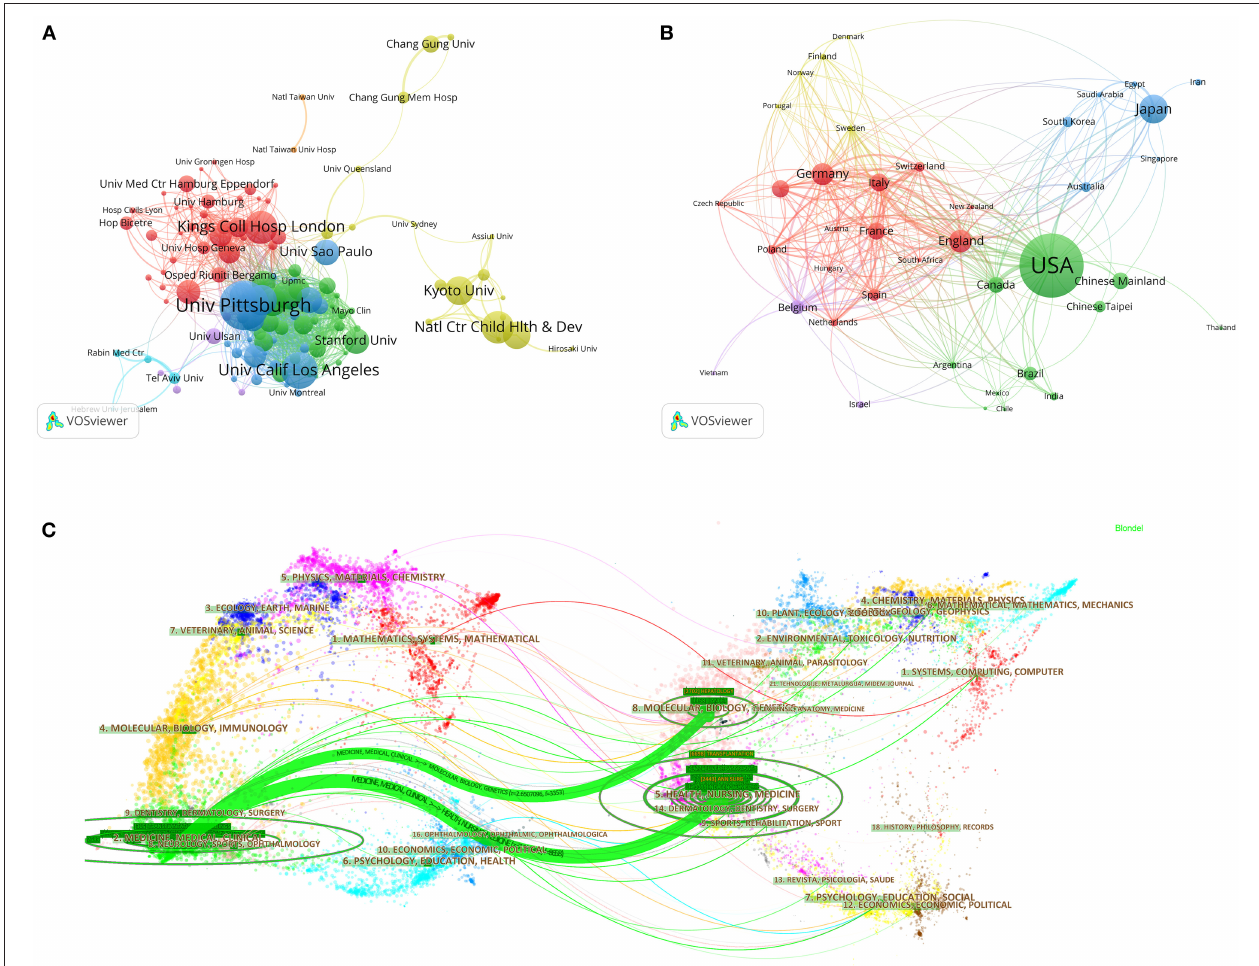
FIGURE 2 | The collaboration status of pediatric liver transplantation (PLT). (A) Network of institutions created by VOSviewer. The resolution in the action panel was set at 0.8. The weight in the options panel was set as “documents.” Node size means the occurrence times of the institutions. (B) Network of countries/regions created by VOSviewer. The resolution in the action panel is set at 0.8. The weight in the options panel is set as “documents.” Node size means the occurrence times of the regions. (C) Dual-map overlay of the literature about PLT. Each dot on the left or right side represents a journal. The dots on the left side compose the citing journal map, and the dots on the right side compose the cited journal map. Labels are extracted from journal titles and show the disciplines involved in the series. The lines are citation links, beginning from the left and pointing to the journals on the right. The size of the oval means how many people are in terms of authors and how many papers are published in those